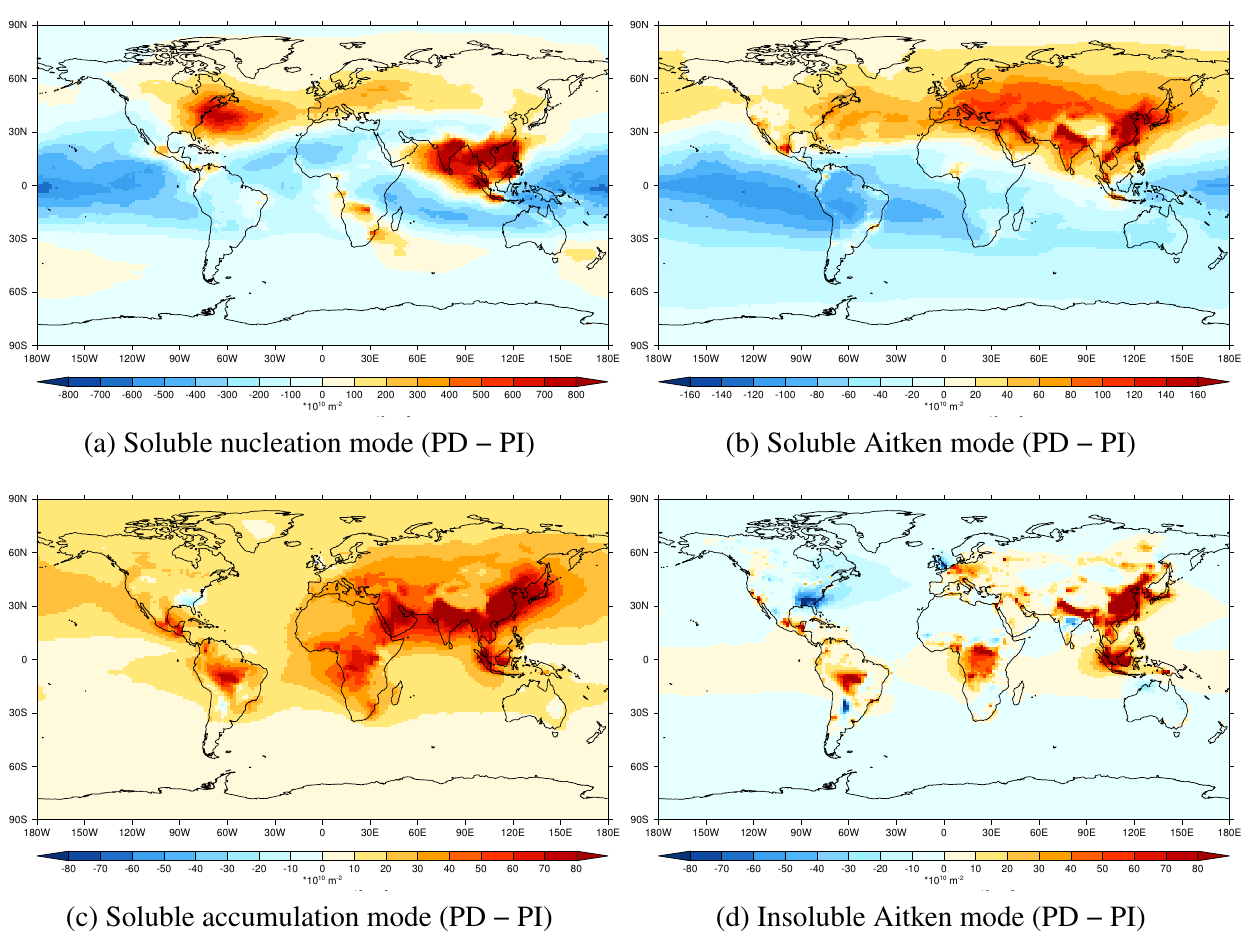
Figure 12. Change in annual mean aerosol number burden in (a) soluble nucleation mode, (AWM = − 57 . 00 × 10 10 m − 2 ) (b) soluble Fig. 12 : Change in annual mean aerosol number burden in (a) soluble nucleation mode, Aitken mode (AWM = − 13 . 02 × 10 10 m − 2 ), (c) soluble accumulation mode (AWM = 19 . 47 × 10 10 m − 2 ), and (d) insoluble Aitken mode (AWM = − 57 . 00 × 10 10 m − 2 ) (b) soluble Aitken mode (AWM = − 13 . 02 × 10 10 m − 2 ), (c) sol- (AWM = 3 . 13 × 10 10 m − 2 ). Maps show differences between pairs of simulations of model sigw0.4 with pre-industrial and present-day aerosol uble accumulation mode (AWM = 19 . 47 × 10 10 m − 2 ), (d) insoluble Aitken mode (AWM =